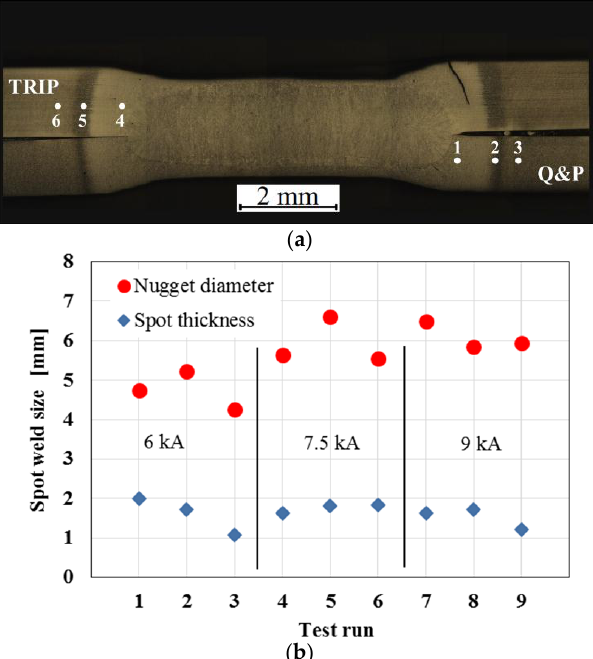
Figure 4. Q&P/TRIP spot weld: ( a ) typical cross section appearance and ( b ) average nugget diameter and joint thickness obtained for the different welding conditions. The numbers from 1 to 6 define the locations of the microstructures displayed in Figure 5.